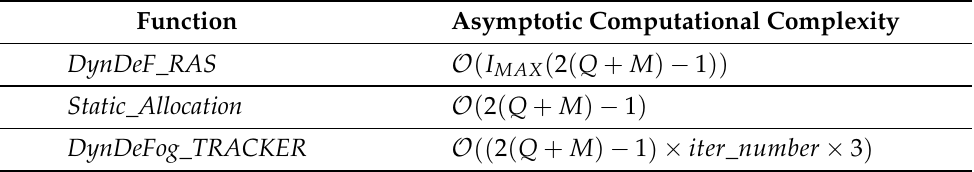
Table 4. A synoptic overview of the computational complexities of the main functions supported by the DeepFogSim toolkit.